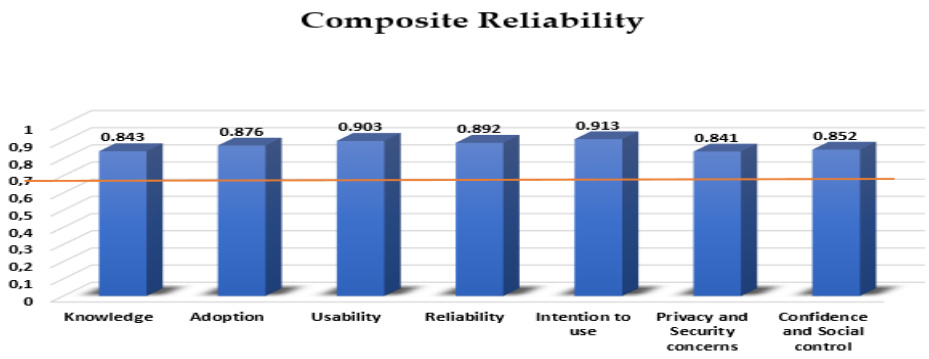
Figure 2 . Composite Reliability . Figure 2. Composite Reliability.